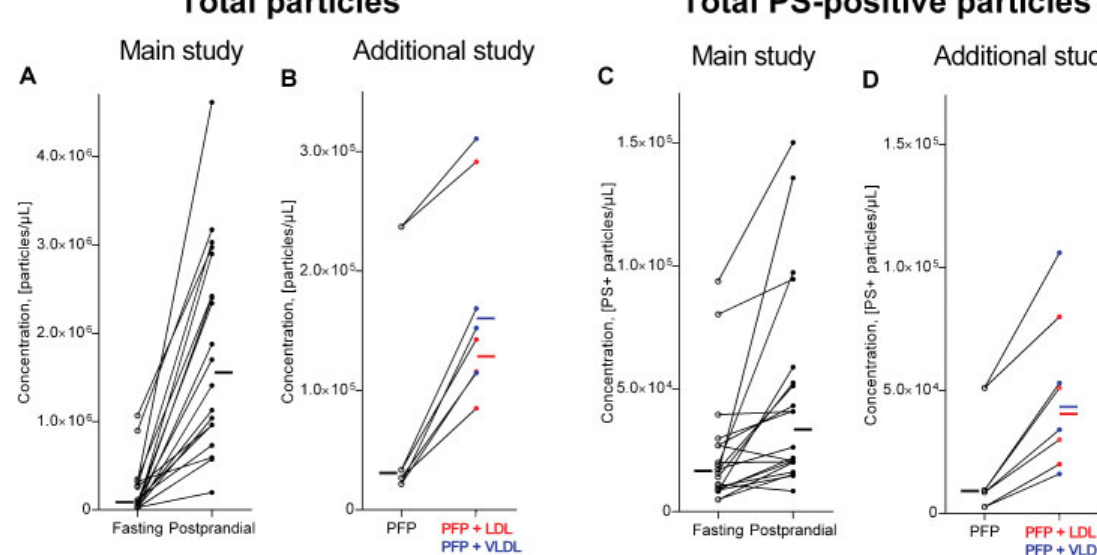
Fig. 1 Fasting and postprandial concentration of ( A ) total particles and ( C ) phosphatidylserine-positive (PS þ ) particles measured by fl ow cytometry and, for comparison, fasting plasma before and after addition of VLDL or LDL ( B and D ). Lines combine fasting levels ( open circles ) with postprandial levels ( closed circles ) for each study participant, and for the additional study the levels before ( open circles ) and after addition of VLDL ( blue closed circles ) and LDL ( red closed circles ). Small bars to the left of the fasting and to the right of the postprandial results (or after addition of VLDL [ blue ] or LDL [ red ]) indicate the median of all